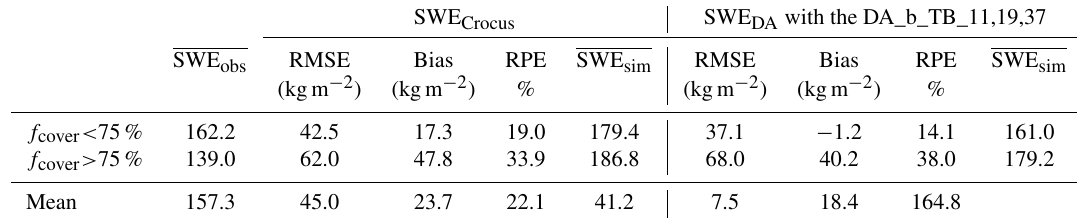
Table 6. Averaged SWE RMSE, bias, and RPE (Eq. 12) over the 43 winters for original SWE simulation (SWE Crocus ) and assimilated SWE DA (Experiment B). Statistical performances were estimated for SWE obs > 48kgm − 2 (snow depth higher than ∼ 20cm). SWE obs and SWE sim are the averaged observed and simulated SWE,